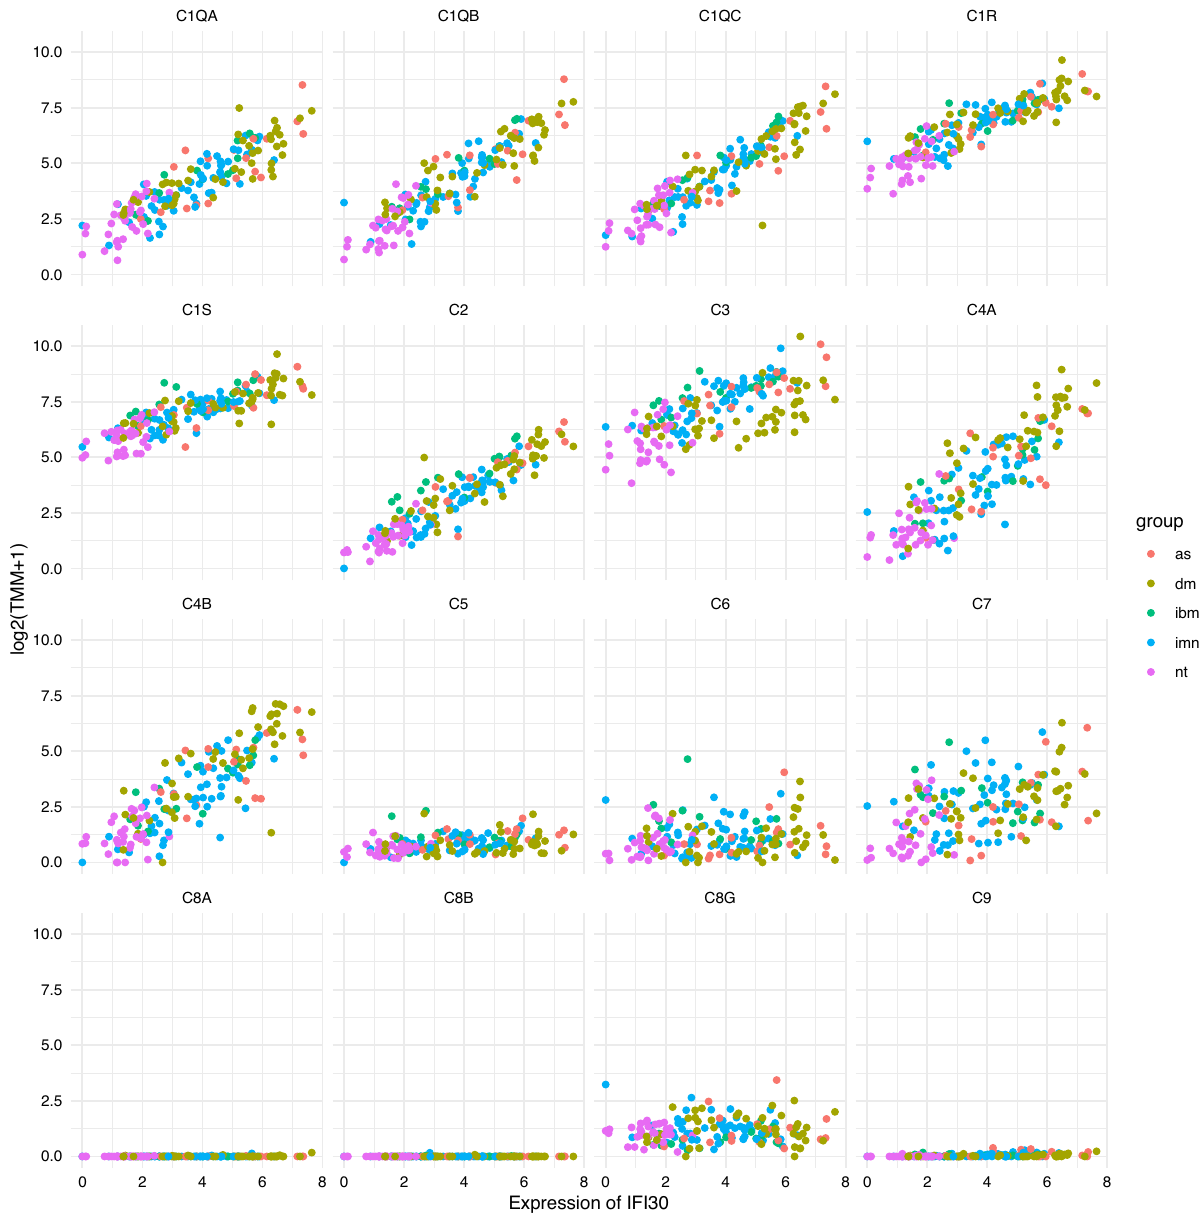
Figure 4. Correlation of IFI30 with complement genes in normal muscle and different types of inflammatory myopathy. The expression of IFI30, an IFNg-stimulated gene, strongly correlates with the expression of the initial components of the complement cascade. nt, normal tissue; dm, dermatomyositis; as, antisynthetase syndrome; imnm, immune-mediated necrotizing myositis; ibm, inclusion body